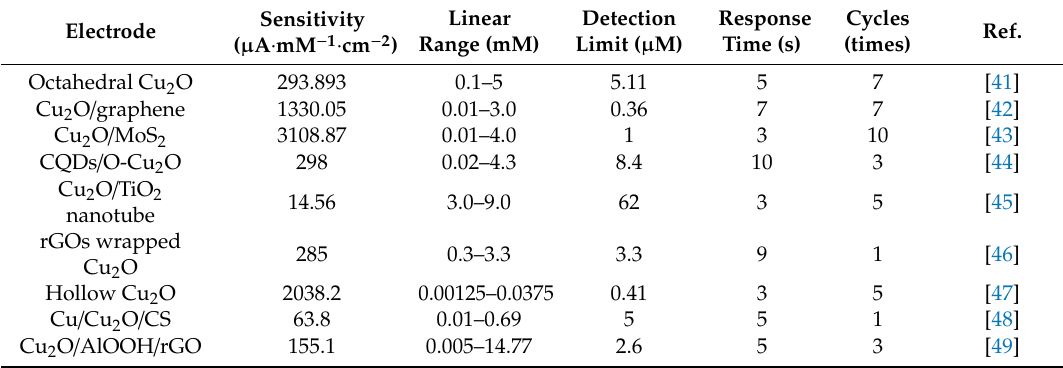
Table 1. Comparison of di ff erent glucose sensors